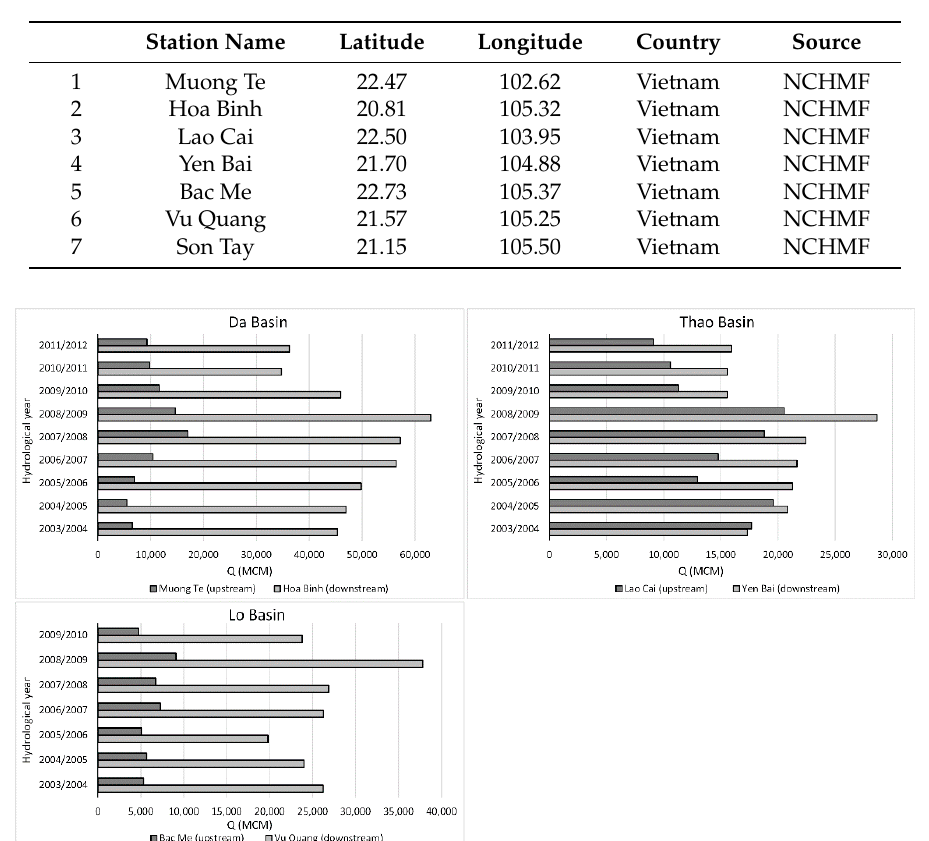
Table A2. Metadata of streamflow stations.